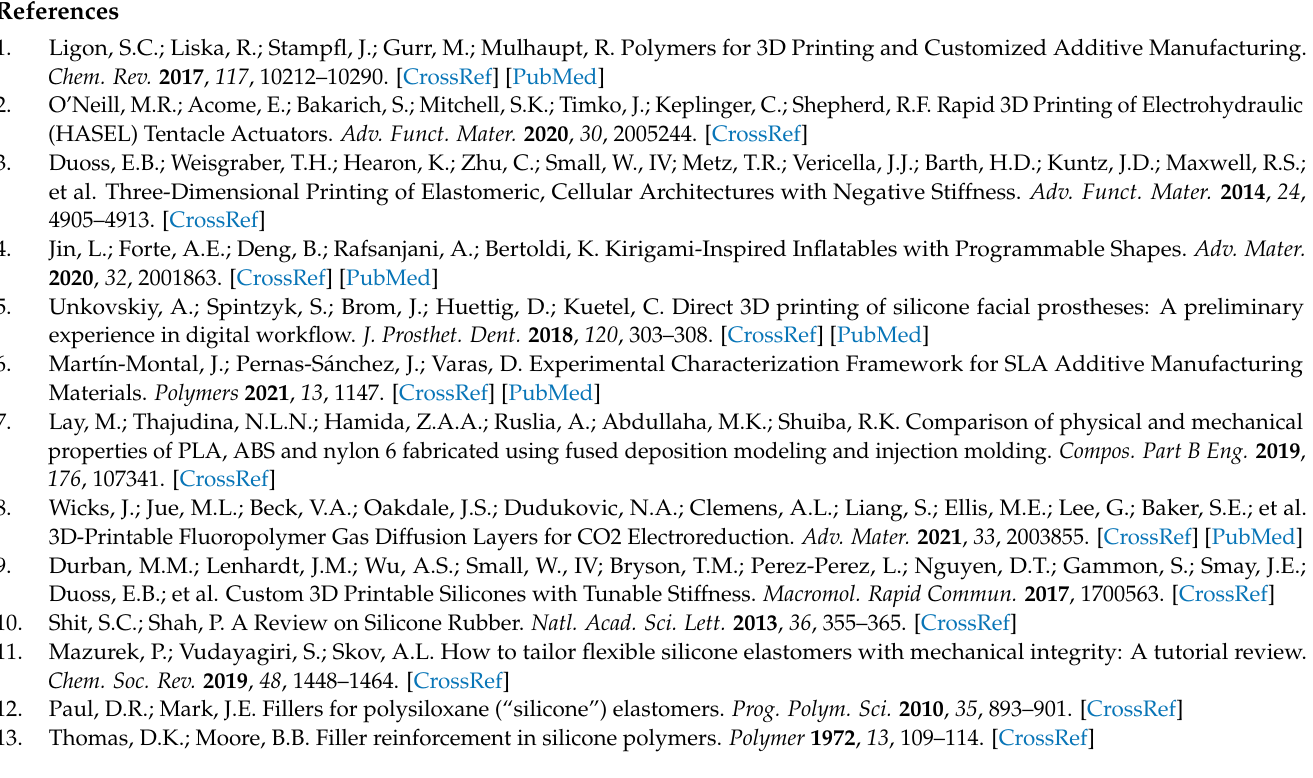
diameter. Table S1: Solubility of photo-initiator components in TEMQ-1. Figure S2: Viscosity of VTS-2 + MFS-1 as a function of silica content. Figure S3: ASTM D638 tensile testing for TEFS-1 through TEFS-4 compared to ‘bulk’ specimen. Figure S4: Tensile data for TEFS-1 specimens. Figure S5: Tensile data for TEFS-2 specimens. Figure S6: Tensile data for TEFS-3 specimens. Figure S7: Tensile data for TEFS-4 specimens. Figure S8: DSC analysis of TEFS1–4. Figure S9: Resin Shear modulus as a function of filler concentration (wt%). Figure S10: Tensile data for TEFS-5 specimens. Figure S11: Tensile data for TEFS-6 specimens. Figure S12: Tensile data for TEMQ-1 specimens. Figure S13: Tensile data for TEMQ-2 specimens. Figure S14: Tensile data for TEMQ-3 specimens. Figure S15: Tensile data for TEMQ-4 specimens. Figure S16: Layer thickness as a function of photo-absorber. Figure S17 Stress vs. strain data for a TEFS-3 octet truss lattice compressed to 87% strain. Video S1: CT Reconstruction of Silicone